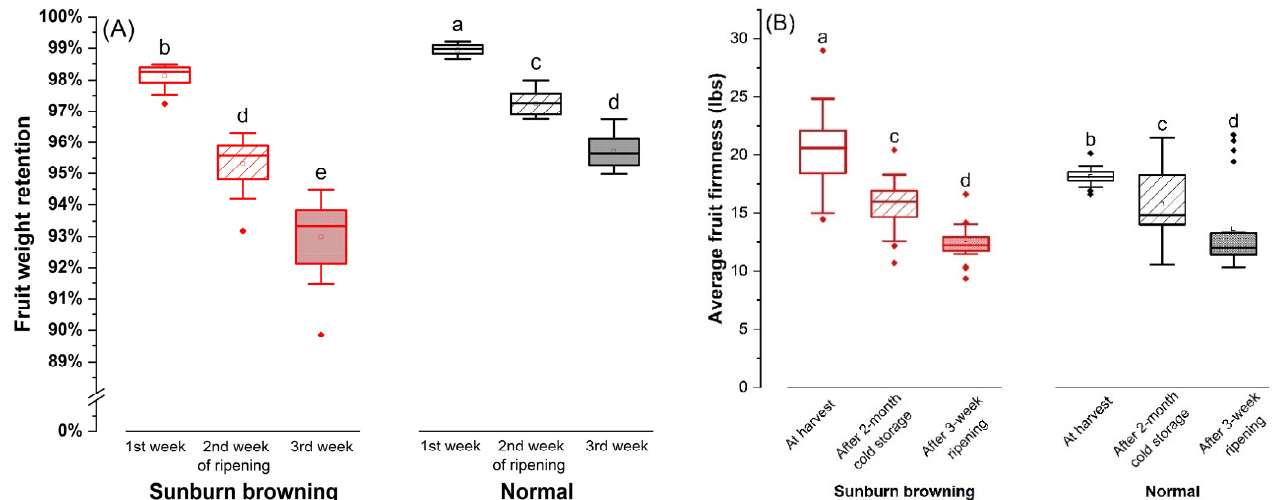
Figure 5. Fruit weight retention and firmness retention of normal and sunburn browning ‘Ambrosia’ apple during storage and ripening: ( A ) weight retention levels during the 1st, 2nd, and 3rd week of ripening at 20 °C; ( B ) loss of fruit firmness after 2-month air storage at 4 °C and subsequent 3-week ripening. Different letters a, b, c, d and e in each subpanel stand for statistical significance at p ≤ 0.05 (ANOVA, Tukey pairwise comparison).